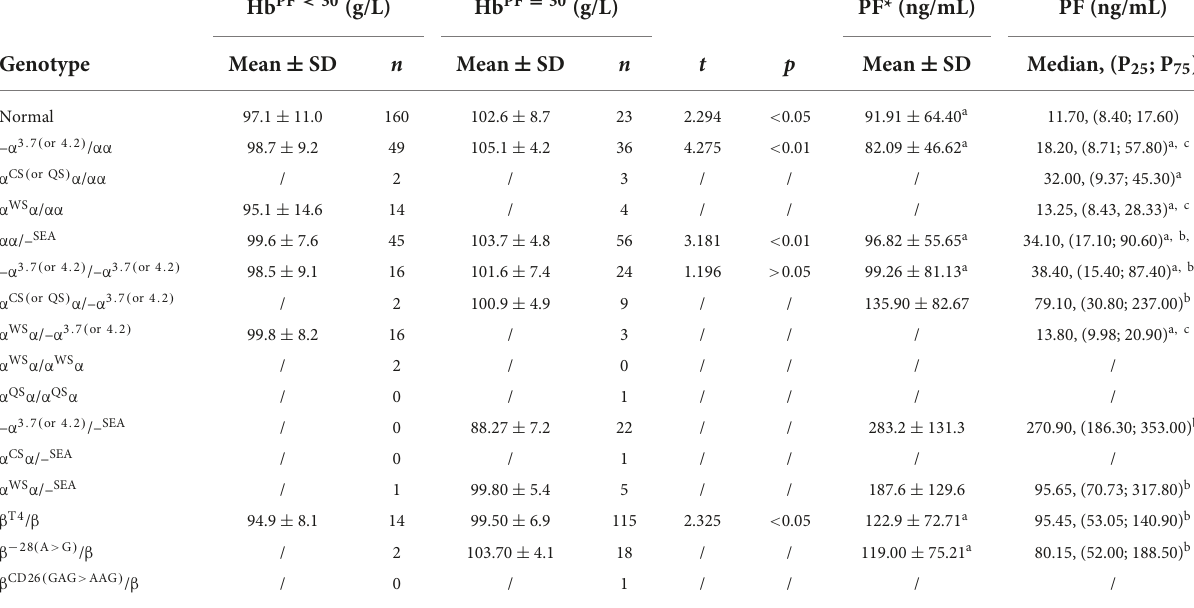
TABLE 2 The levels of Hb and PF in APW with or without